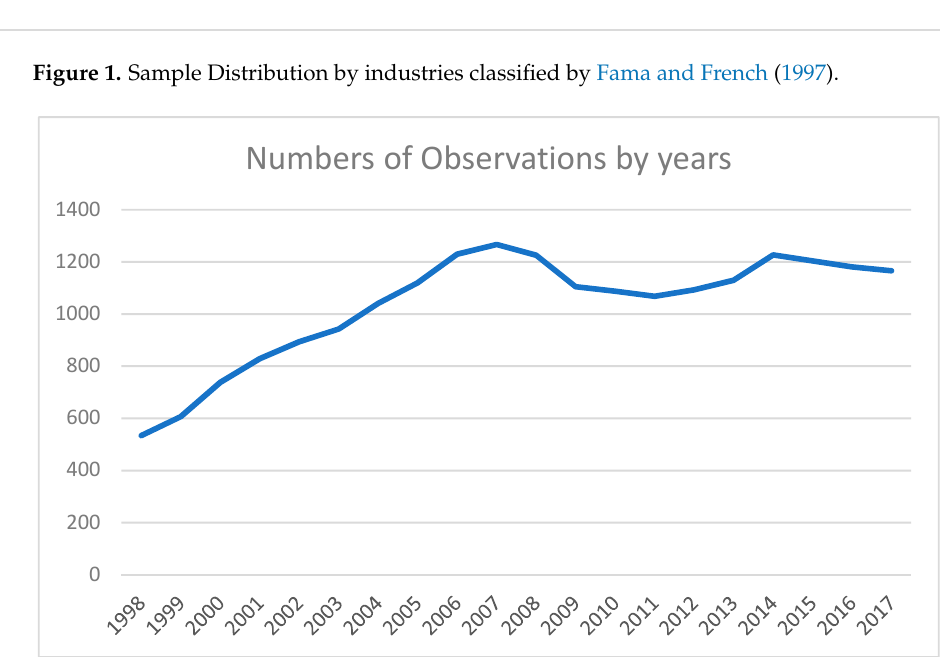
Figure 2. Sample Distribution by years.